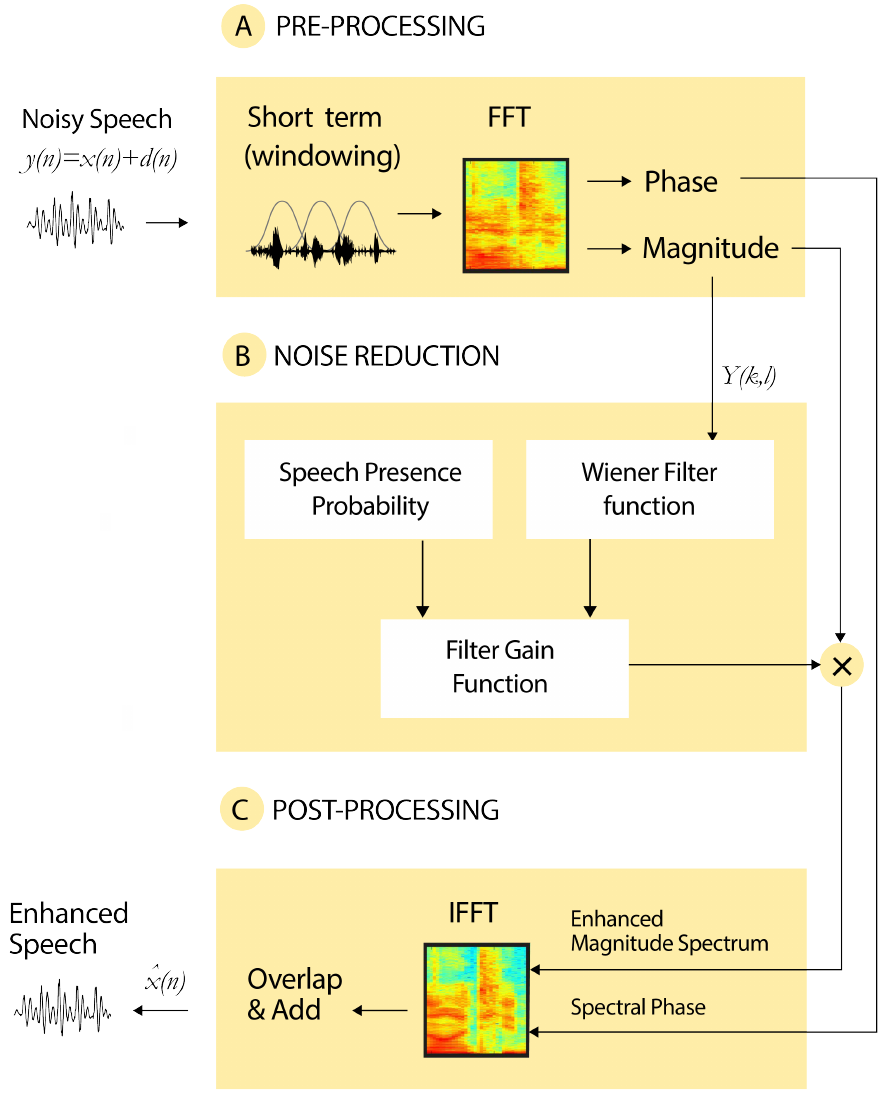
Figure 1. Spectral-domain speech estimator